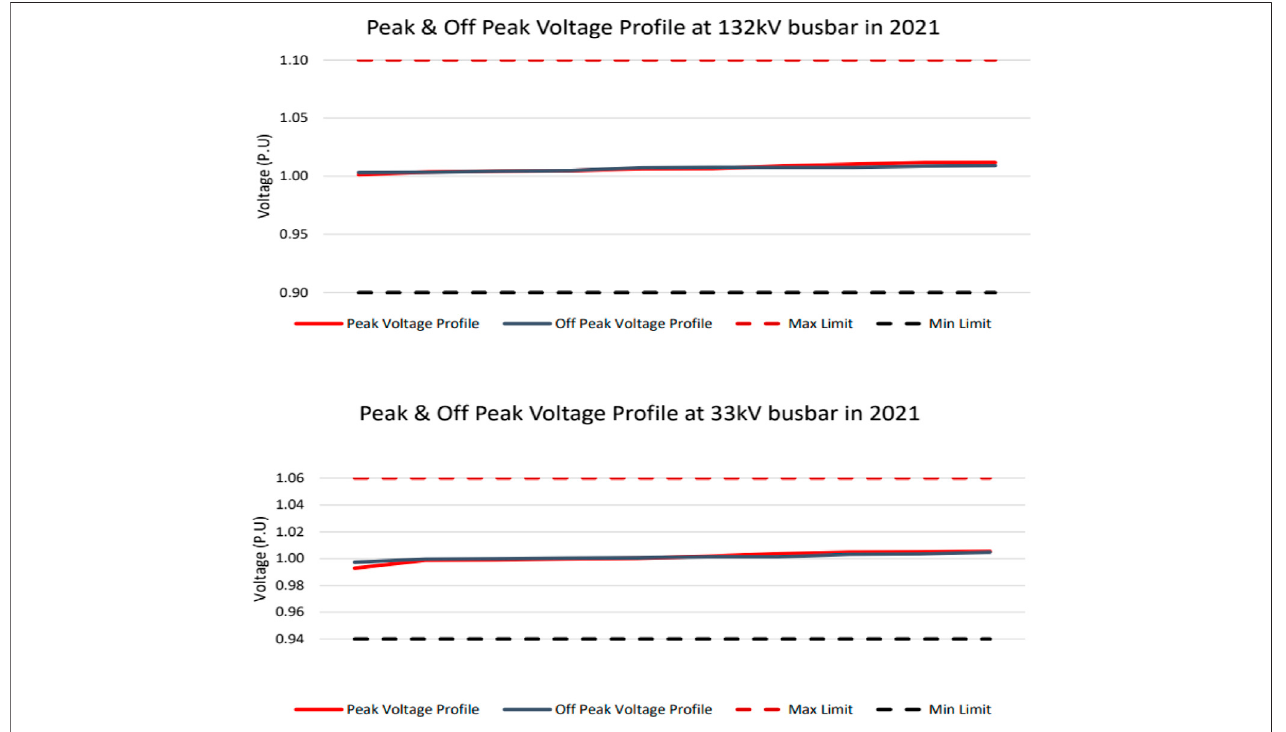
FIGURE 5 | DTS peak and off-peak voltage pro fi les at different power grids in 2021.